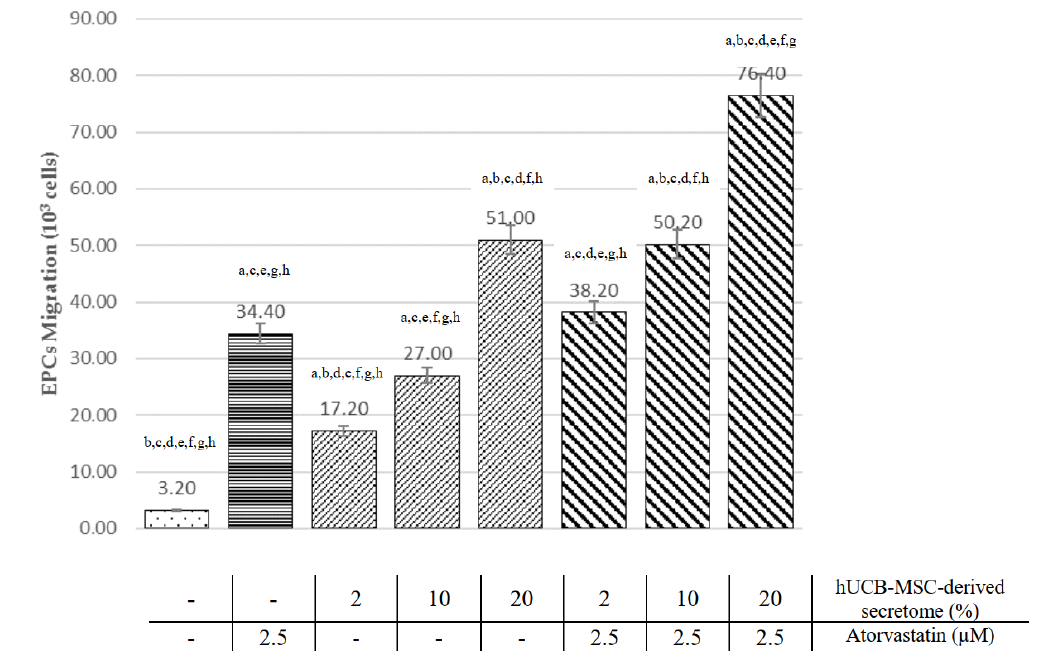
Figure 3. Comparison of EPCs migration effects among all treatment groups (see text). a Significant difference compared to the control group (p < 0.001). b Significant difference compared to the 2.5 µM atorvastatin group (p < 0.001). c Significant difference compared to the 2% hUCB-MSC-derived secretome group (p < 0.001). d Significant difference compared to the 10% hUCB-MSC-derived secretome group (p < 0.001). e Significant difference compared to the 20% hUCB-MSC-derived secretome group (p < 0.001). f Significant difference compared to the combination of 2% hUCB-MSC-derived secretome and atorvastatin group, (p < 0.001). g Significant difference compared to the combination of 10% hUCB-MSC-derived secretome and atorvastatin group, (p < 0.001). h Significant difference compared to the combination of 20% hUCB-MSC-derived secretome and atorvastatin group, (p <